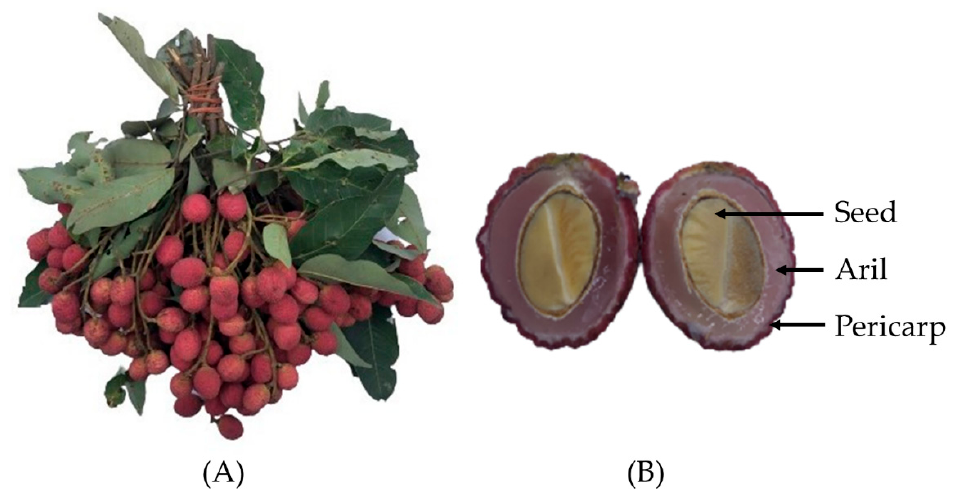
Figure 1. ( A ) A bunch of Nephelium hypoleucum Kurz fruit and ( B ) different parts of the fruit includ- ing aril (edible flesh), pericarp (peel) and